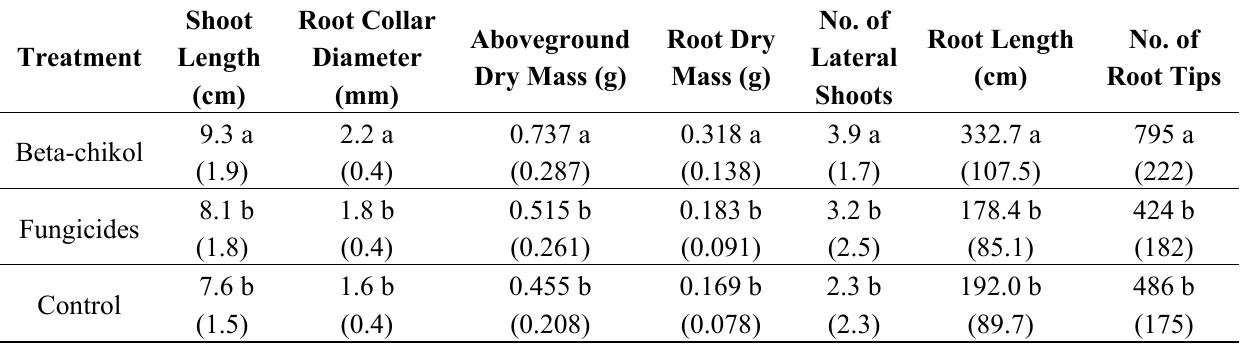
Table 1. Biometric parameters (mean and standard deviation in brackets) of Scots pine ( Pinus sylvestris ) protected with Beta-chikol, fungicides, and of the unprotected control. Treatment